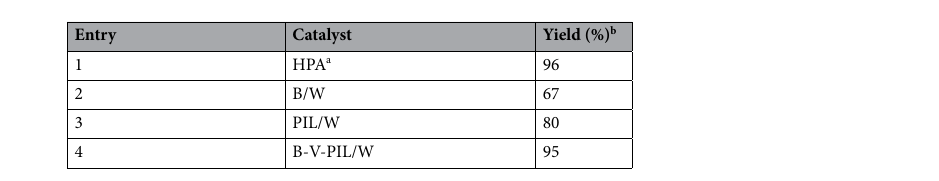
Table 4. Comparison of catalytic activities of B-V-PIL/W and control catalysts for the model oxidation reaction. a Oxidation reaction condition: benzyl alcohol (1 mmol), H 2 O 2 30% (1 mmol), Catalyst (40 mg) in